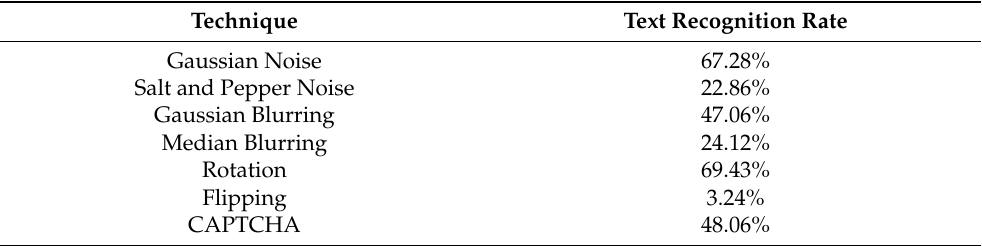
Table 11. Text recognition rate according to the application of OCR evasion techniques.